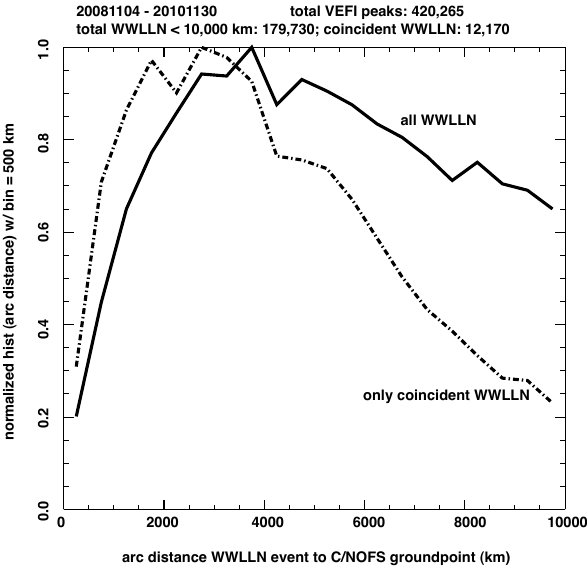
Fig. 15. Histograms of arc distance from stroke location to sub- satellite point. Each histogram is normalized to unity peak for ease of comparison. Solid curve: all WWLLN strokes. Dashed curve: only WWLLN strokes whose propagation-corrected arrival time is coincident ( − 3 to 0ms in Fig. 14 above) with the VEFI peak. then the peak could be made narrower, and this would give a higher histogram